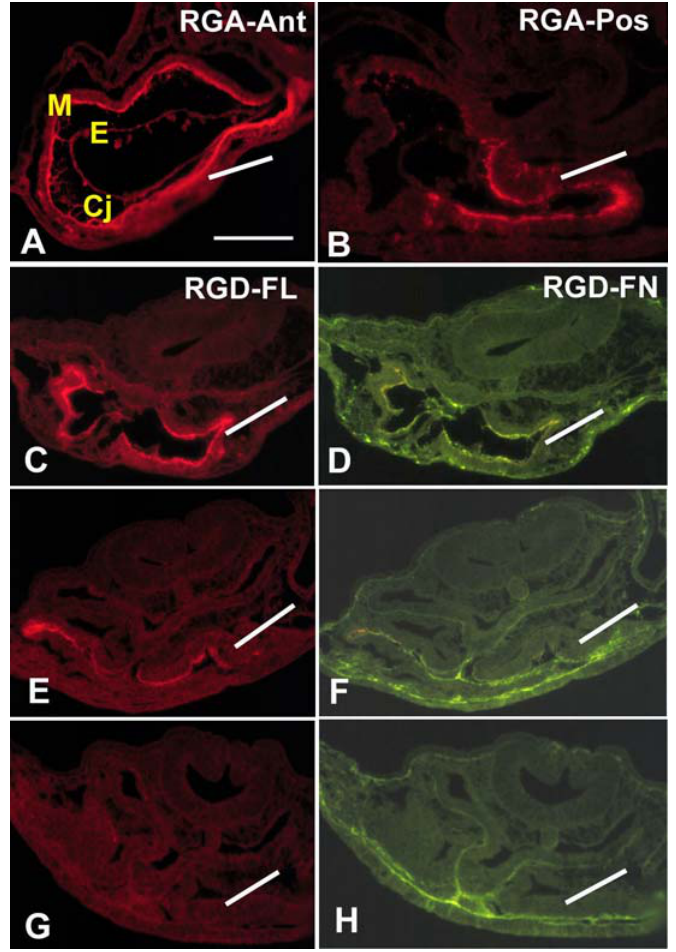
FIGURE 4 . Exposure of HH stage 5 chick embryos to RGD peptides results in an inhibition of normal heart looping and a decrease of FL expression, as well as a decrease in the cardiac jelly compartment of the developing heart. Panels A and B show an embryo that was exposed to control RGA-containing peptides. The heart displays normal FL expression in the basal side of the myocardium and in the cardiac jelly as seen in a section through the anterior (Ant) part of the looping heart (A), and in a more posterior (Pos) section through the same heart that continues to show FL expression primarily in the left side of the heart tube (B). Panels C–H depict results of embryonic exposure to RGD-containing peptides. Panels C, E, and G show an anterior to posterior decrease of FL within the developing heart (white lines point to developing cardiac tissue) on exposure to the RGD peptide in relation to FN in panels D, F, and H that continues to be expressed throughout the heart regions. It is also evident that there is a decrease in ECM production of the cardiac jelly with RGD-peptide inhibition. Magnification bar = 120 μ